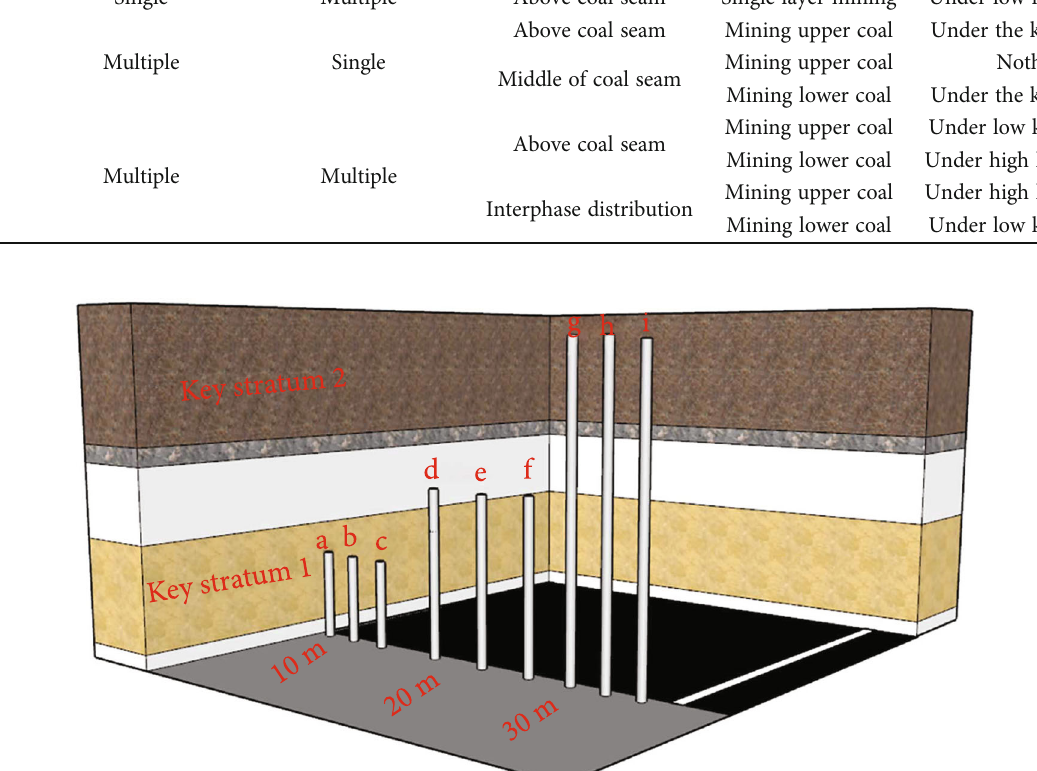
Figure 12: Layout of measuring